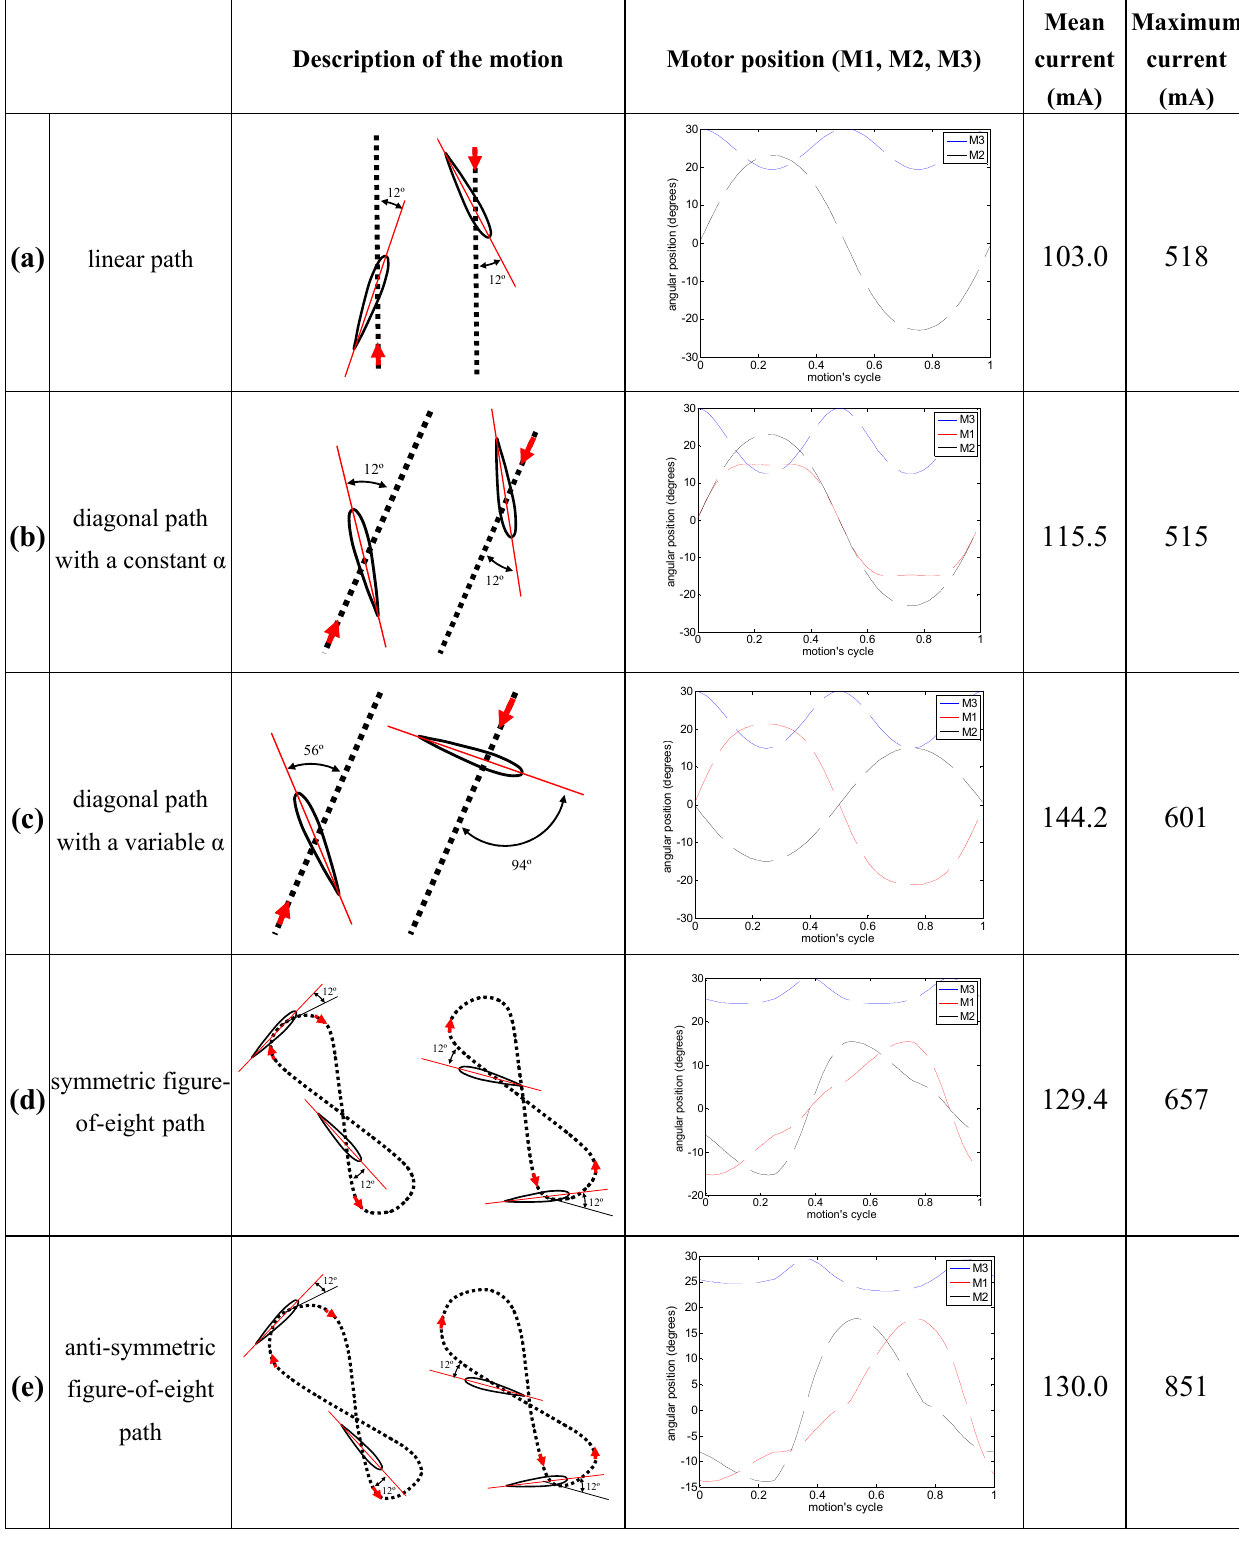
Table 2. Propulsion